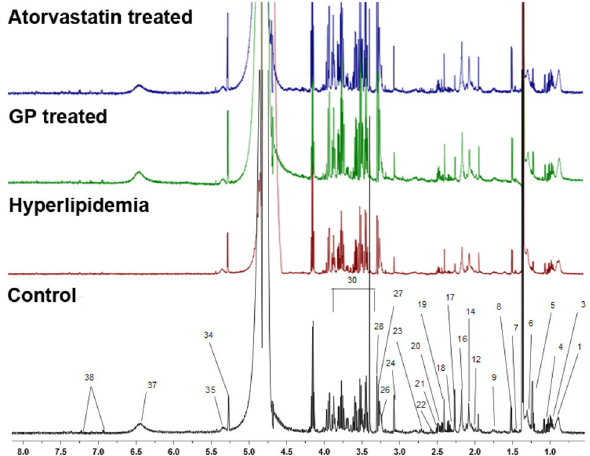
Figure 1. Typical 600 MHz 1 H-NMR spectra of rat plasma samples. 1.Lipids (VLDL/LDL) 3. Isoleucine 4. Valine